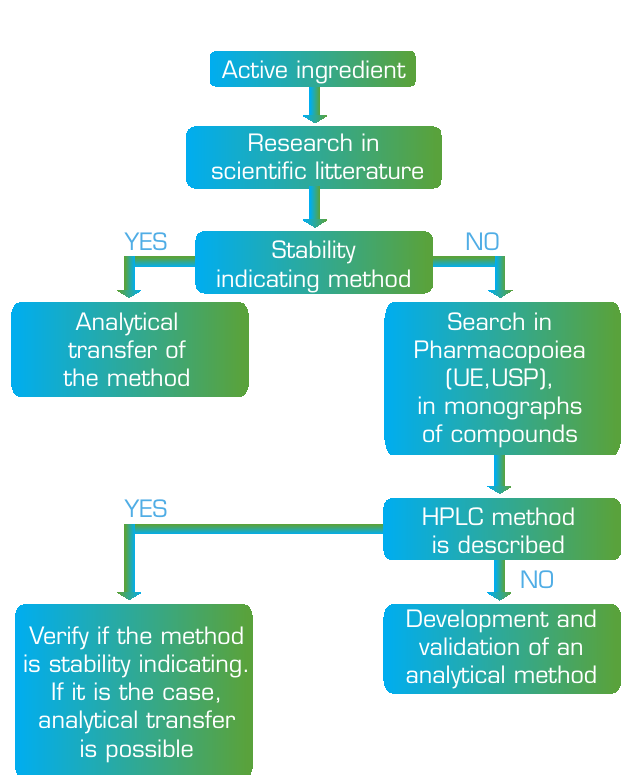
Figure 6: Determining an analytical method suitable for stability studies on an active